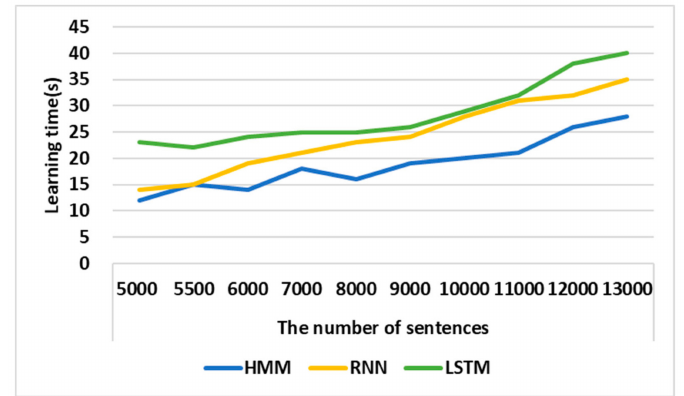
Figure 11. Performance Analysis of HMM. LSTM, long short-term